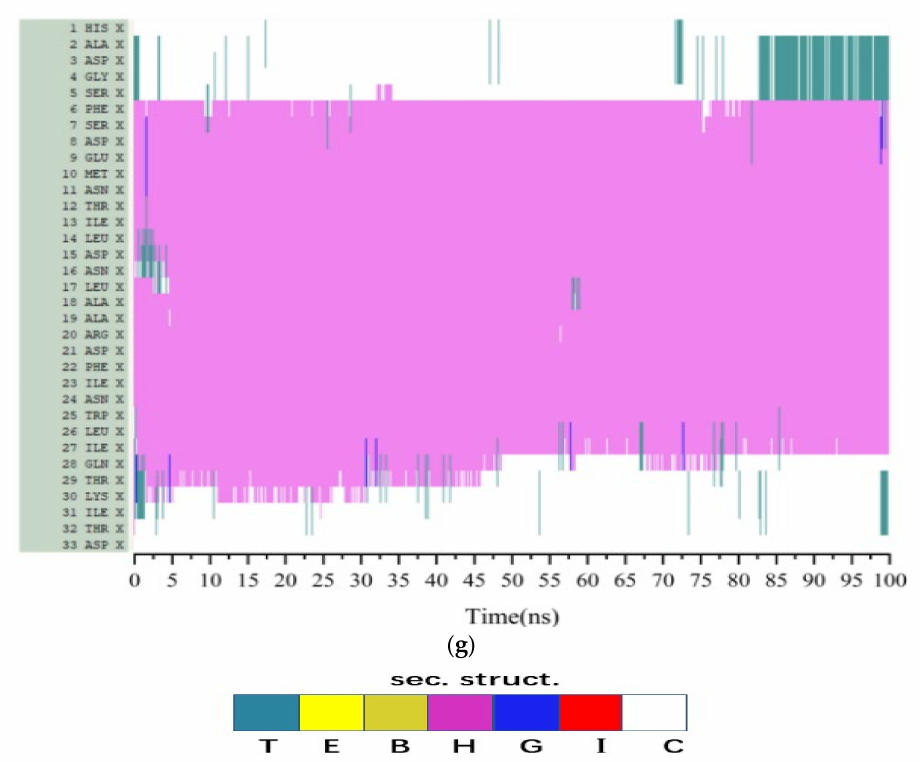
Figure 3. Stride evolution of secondary structures of the protein GLP-2 at different electric field strength. ( a ) E = 0 V/nm, ( b ) E = 0.2 V/nm, ( c ) E = 0.4 V/nm, ( d ) E = 0.5 V/nm, ( e ) E = 0.6 V/nm, ( f ) E = 0.8 V/nm, ( g ) E = 1 V/nm. (Color code: magenta color denotes α -helix, red denotes π -helix, cyan denotes turn, blue denotes 3–10 helix and white denotes